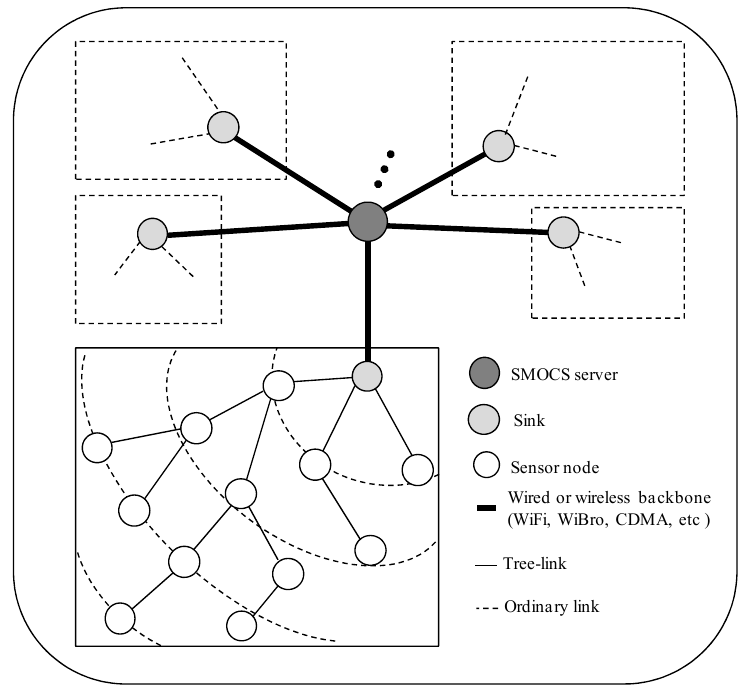
Figure 1. An illustration of a network model for a SMOCS system.